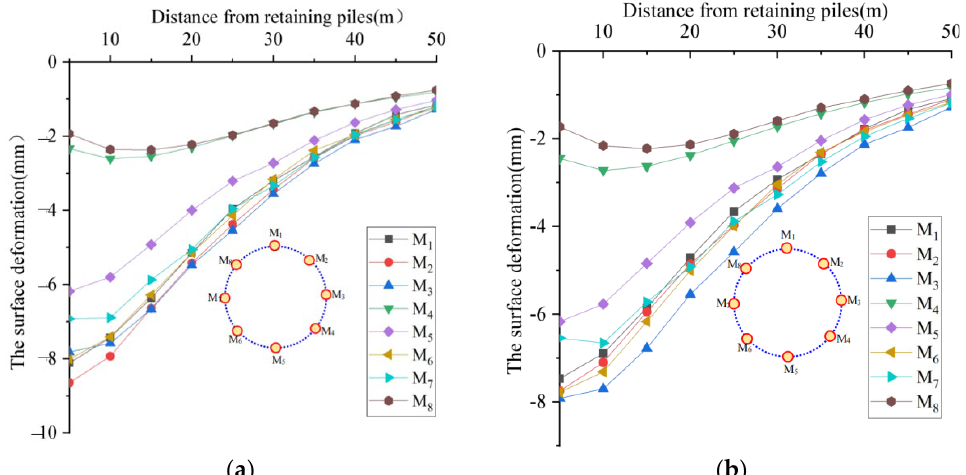
Figure 16. The deformation characteristics of the ground surface. ( a ) working Condition 4. ( b ) work- ing Condition 5.